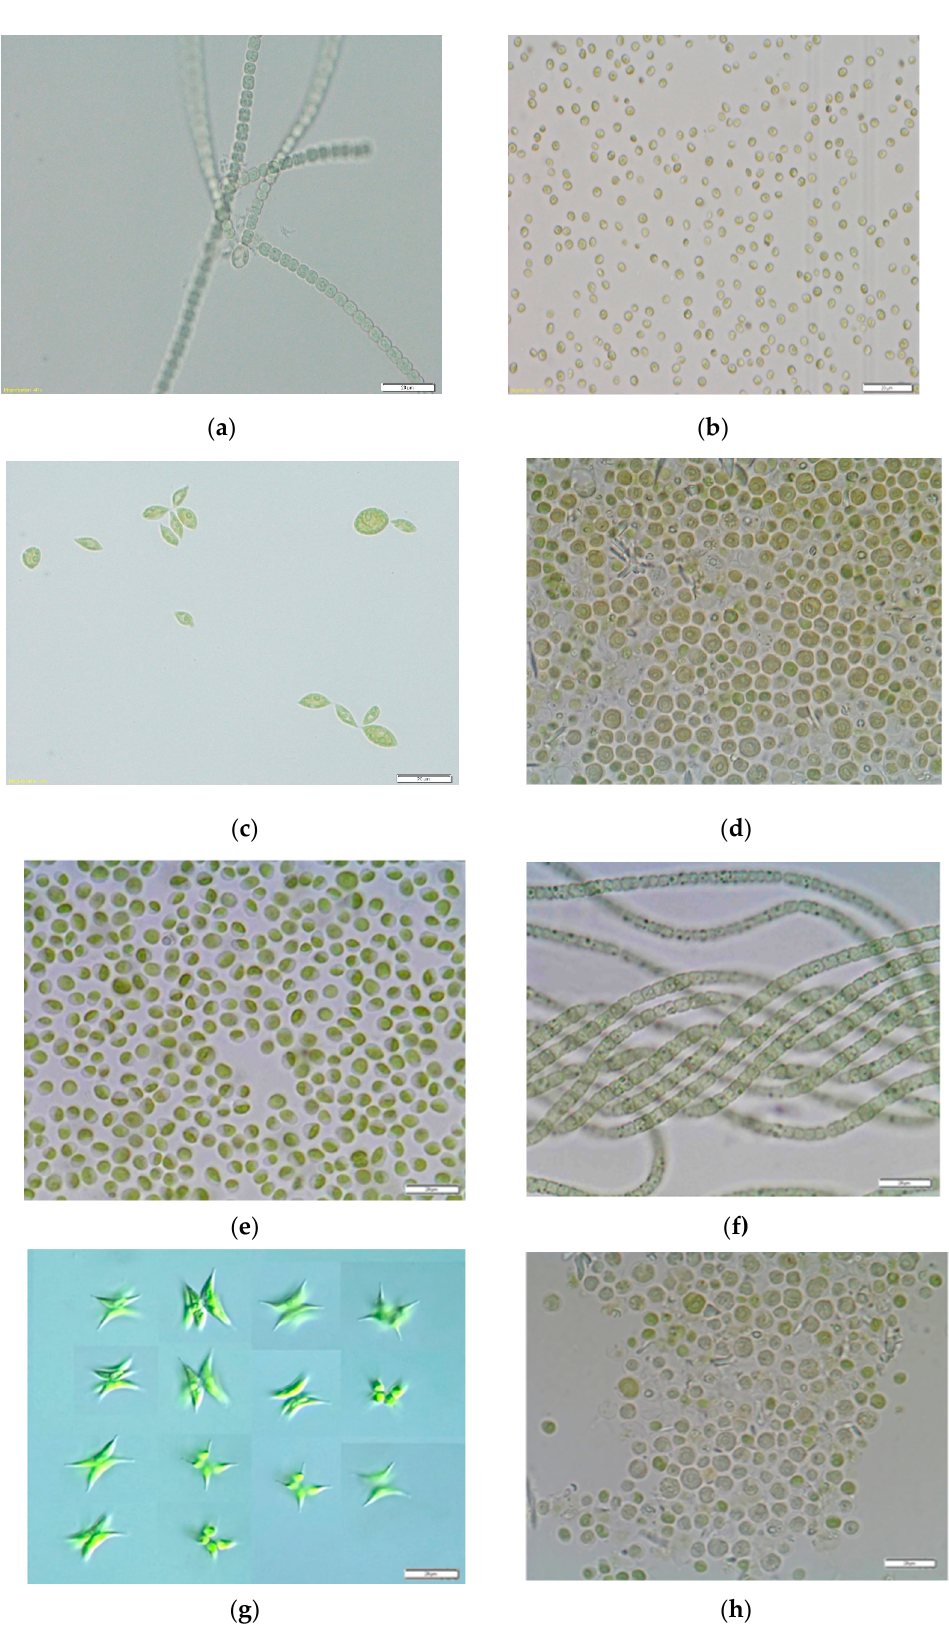
Figure 1. Images of the eight strains involved in the initial germination test ( a ) MACC-683, ( b ) MACC-755, ( c ) MACC-430, ( d ) MACC-922, ( e ) MACC-519, ( f ) MACC-612, ( g ) MACC-677, ( h ) MACC-438. The bar in the figure indicates 20 µm.